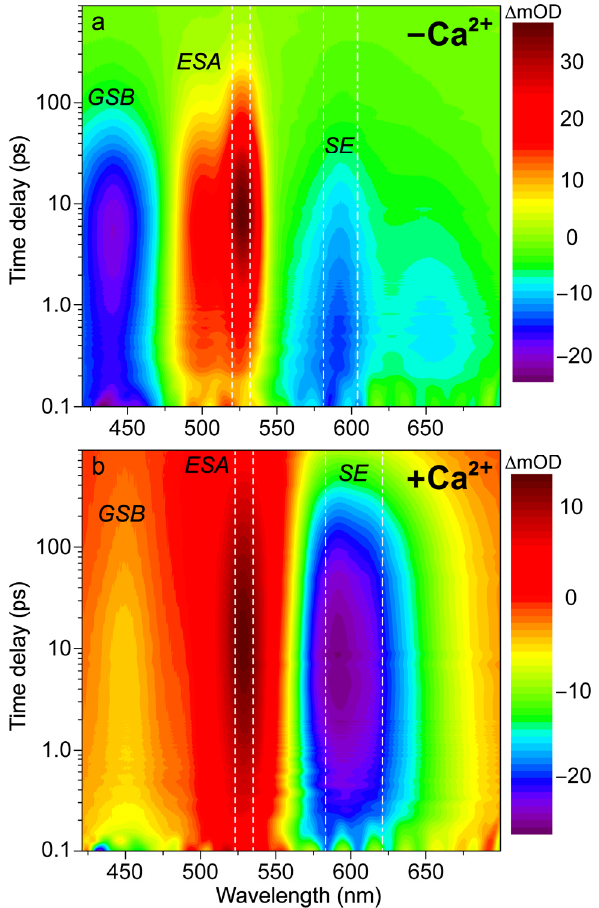
Figure 2. Contour plots of fs-TA spectra of REX-GECO1 biosensor in pH 7 buffer ( a ) without and ( b ) with calcium ions. Upon 400 nm excitation, the Ca 2+ -free (–Ca 2+ ) and -bound (+Ca 2+ ) biosensors display transient electronic features including ground-state bleaching (GSB), excited-state absorption (ESA), and stimulated emission (SE) bands over the experimental time window spanning 900 ps. The signal intensity is shown by the color bar on the right side of each panel in the unit of milli-optical density (mOD). The vertical white dashed or dash-dotted lines depict the spectral integration region for the TA probe-dependent intensity dynamics presented below.